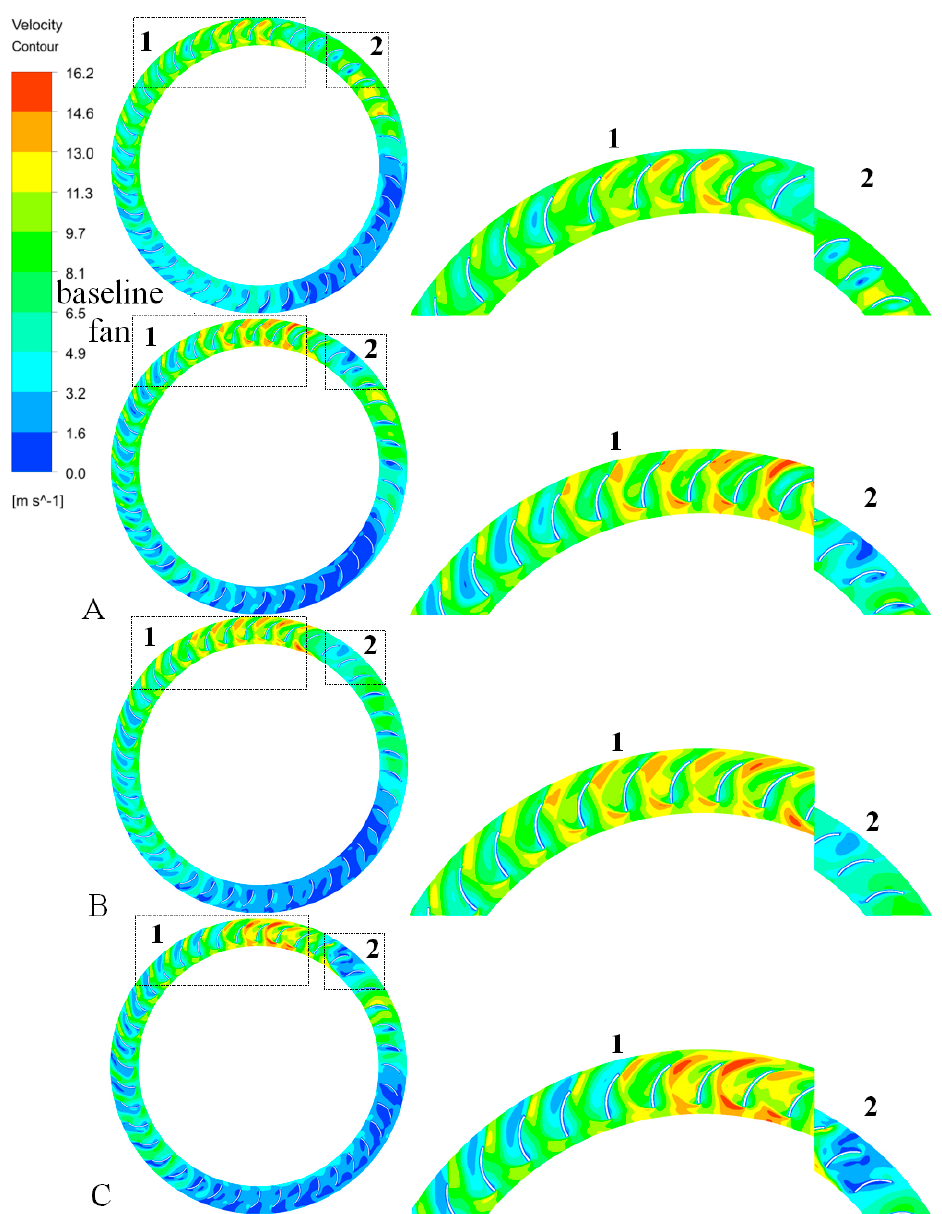
Figure 12. Magnitude of absolute velocity of the impeller for the z = 75 mm plane at a rated flow rate Q / Q n =